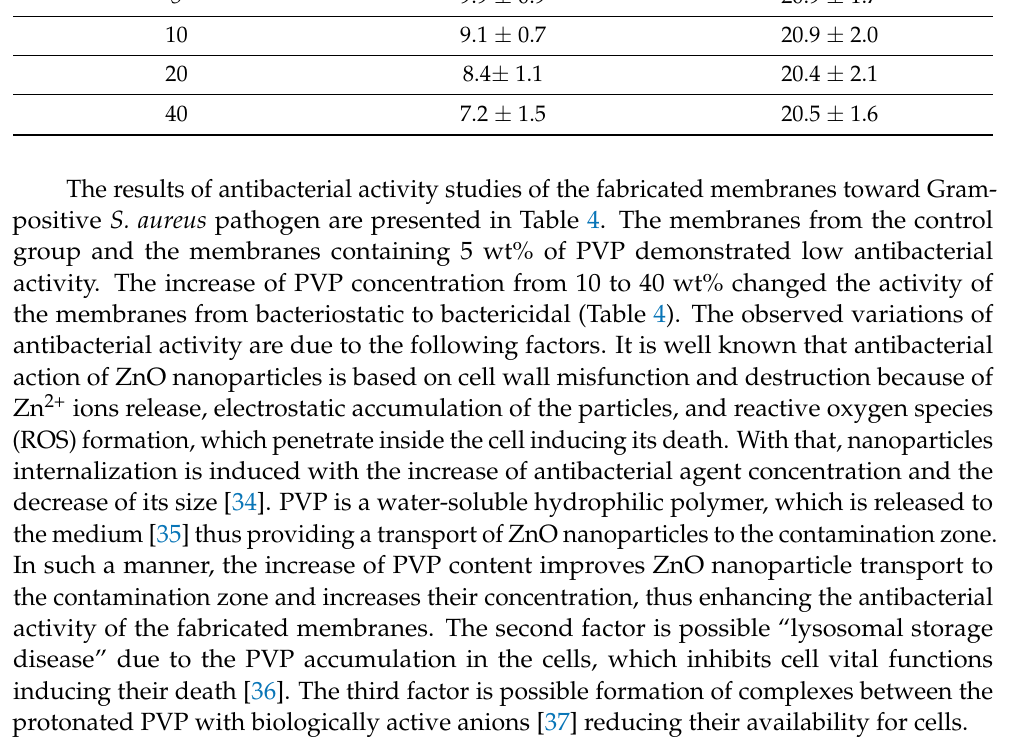
Table 4. Antibacterial activity of VDF-TeFE/PVP/ZnO membranes with various PVP contents. Sample Incubation Time,